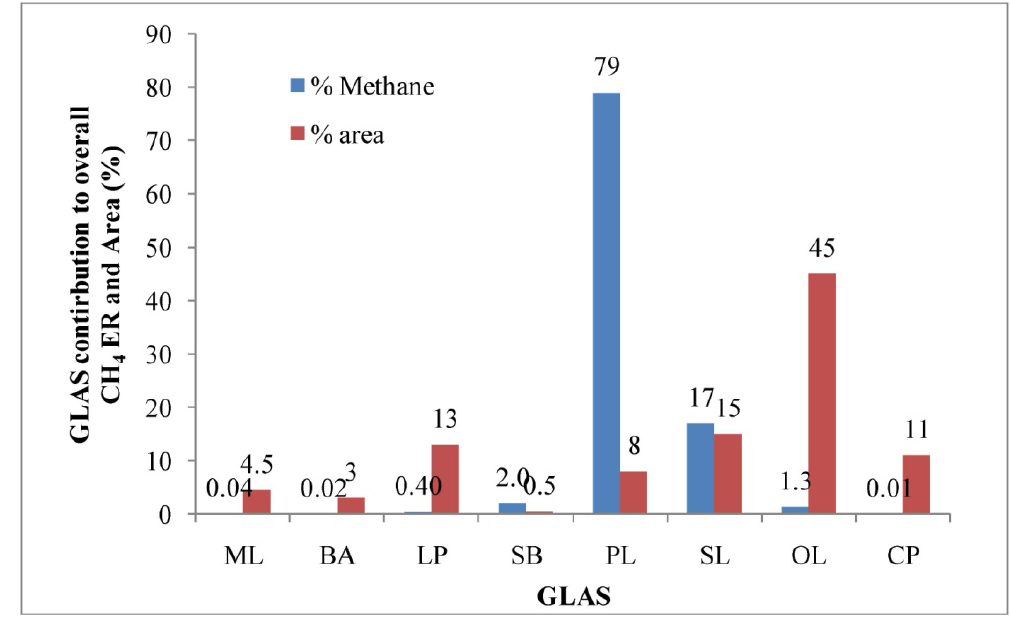
Figure 5. GLAS contribution to overall CH ERs and area at Free-stall dairy during the 4 summer. (Note: ML = manure lane; BA = bedding area; LP = loafing pen; SB = settling basin; PL = primary lagoon; SL = secondary lagoon; OL = open lot; and CP = compost